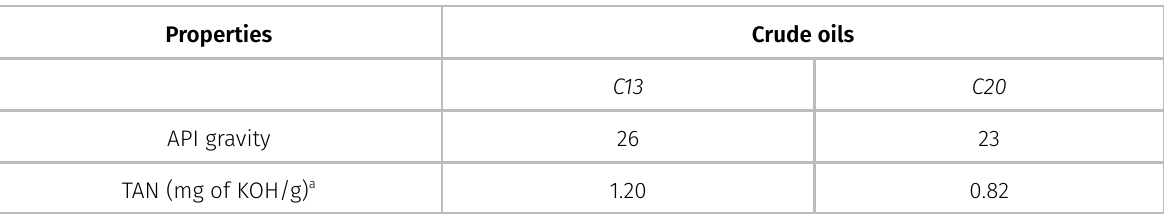
Table I. API and TAN values of the studied crude